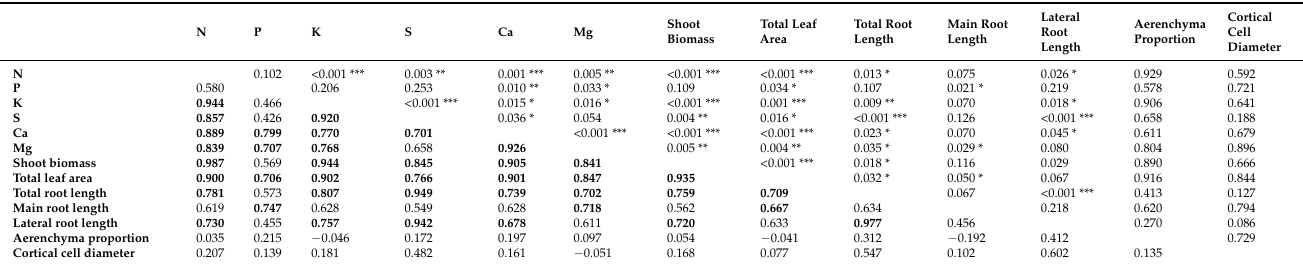
Table 2. Pearson correlation coefficients and significant levels for various traits measured at day 20 for nine spring wheat genotypes.